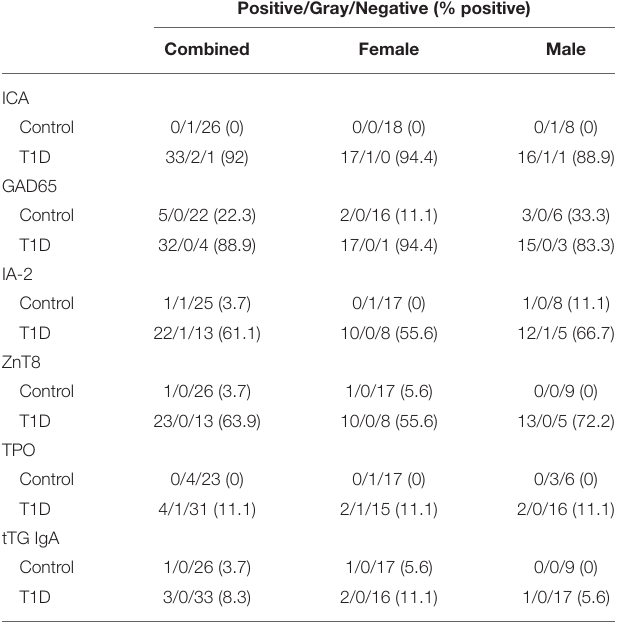
TABLE 2 | Qualitative autoantibody assessment. Positive/Gray/Negative (% positive)